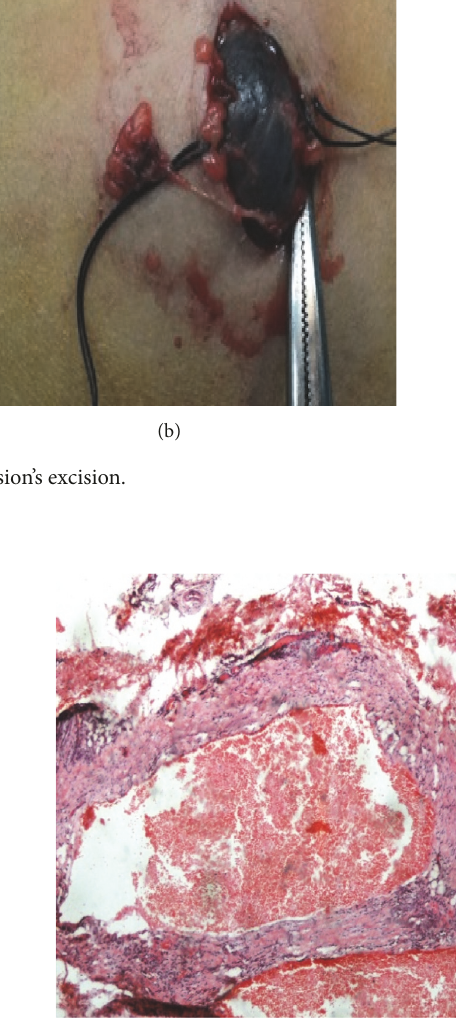
Figure 4: Notice the thickened fibrous capsule of the lymphan- gioma, invested by a flat endothelial layer, on the outer surface of which irregular striated muscle and elastic fibers are found. Thin septula are found within the lesion, while the subcavities are mainly occupied by hemorrhagic material. Notice also the presence of adipose tissue in the vicinity of the lesion (H/E